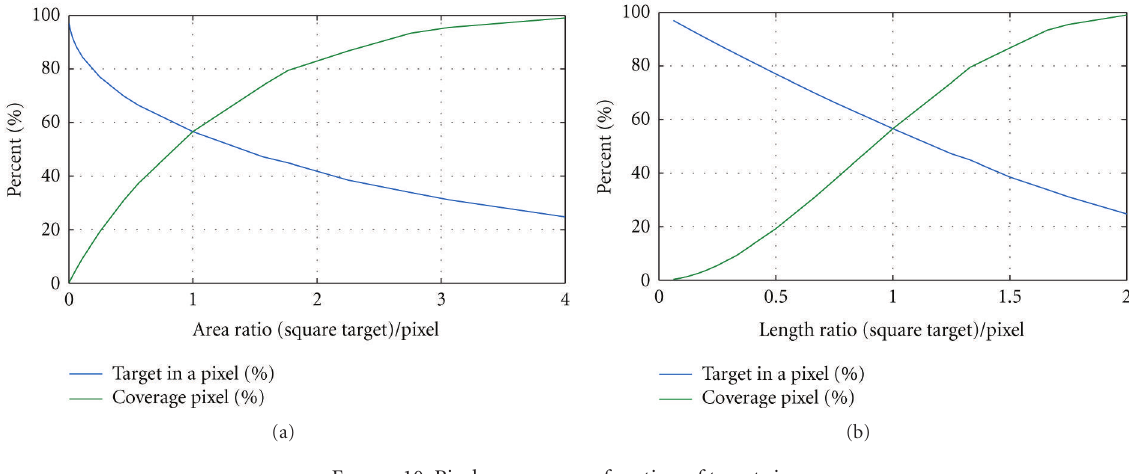
Figure 10: Pixel coverage as a function of target size.